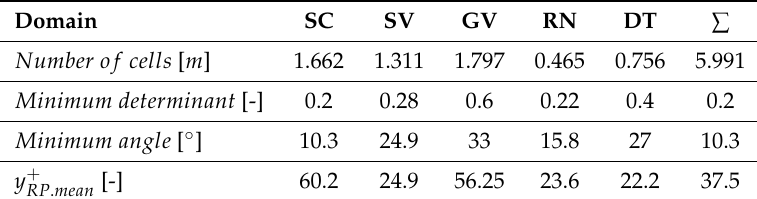
Figure 2. Discretization of the prototype hydro-power plant, ( a ) domains and ( b ) mesh. Table 2. Size and quality of the medium